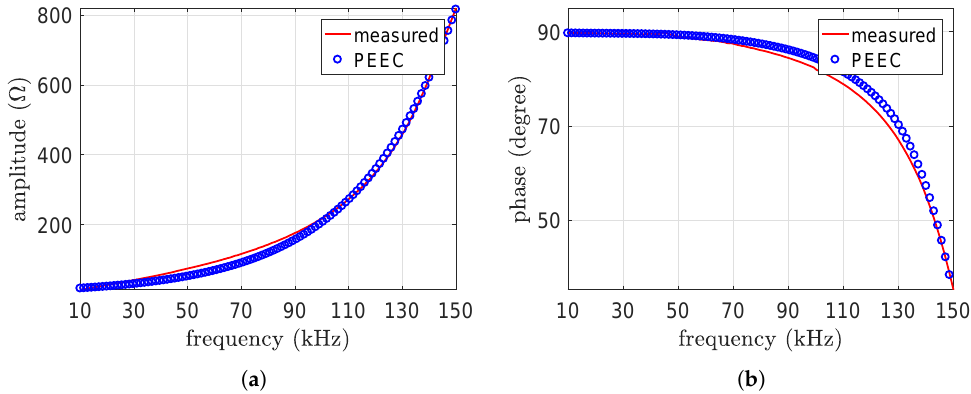
Figure 11. Equivalent impedance of the embedded coil, measures vs. PEEC results. Amplitude ( a ); phase ( b ).